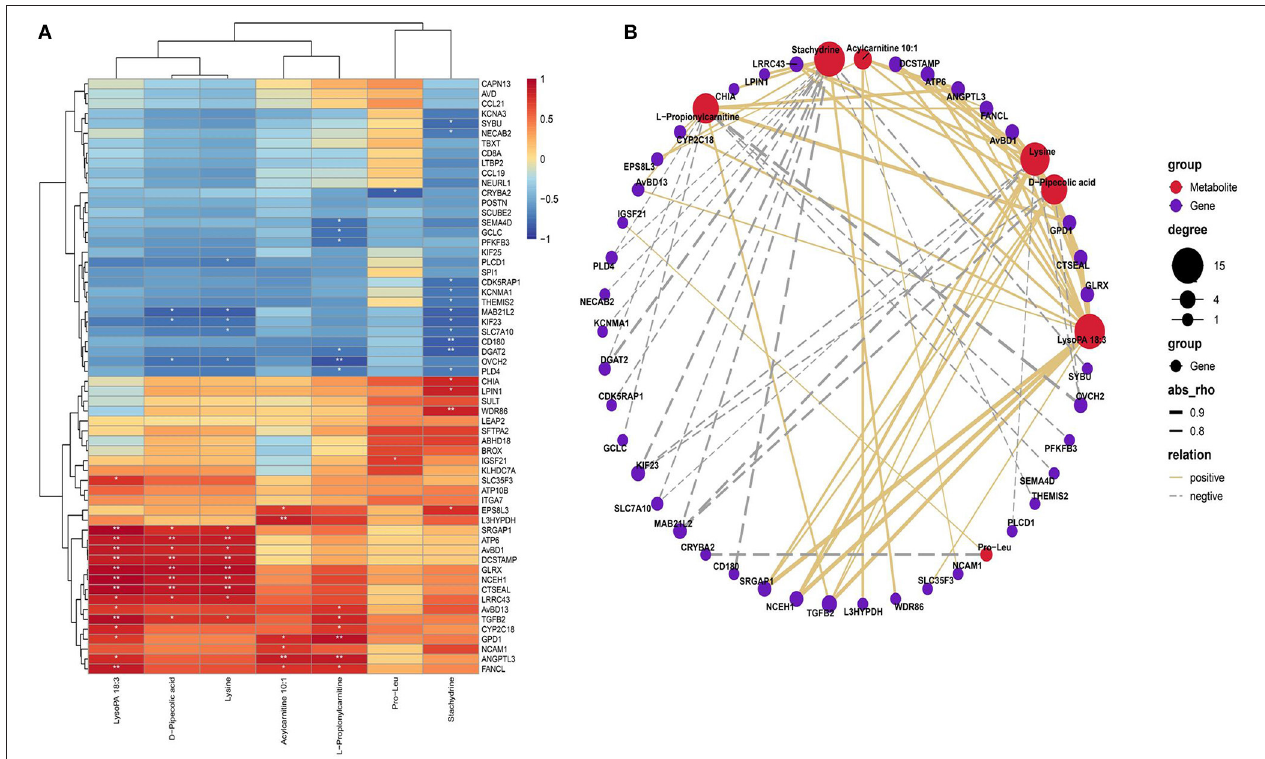
FIGURE 6 | Comprehensive analysis of the SDMs and DEGs. (A) Correlation heatmap of differentially expressed genes and differential metabolites. Color from blue to red indicates a negative correlation to a positive correlation, * P < 0.05, ** P < 0.01. (B) Correlation network diagram of differentially expressed genes and differential metabolites. Only the 20 upregulated and downregulated DEGs are displayed, and the differential metabolites of the top seven are